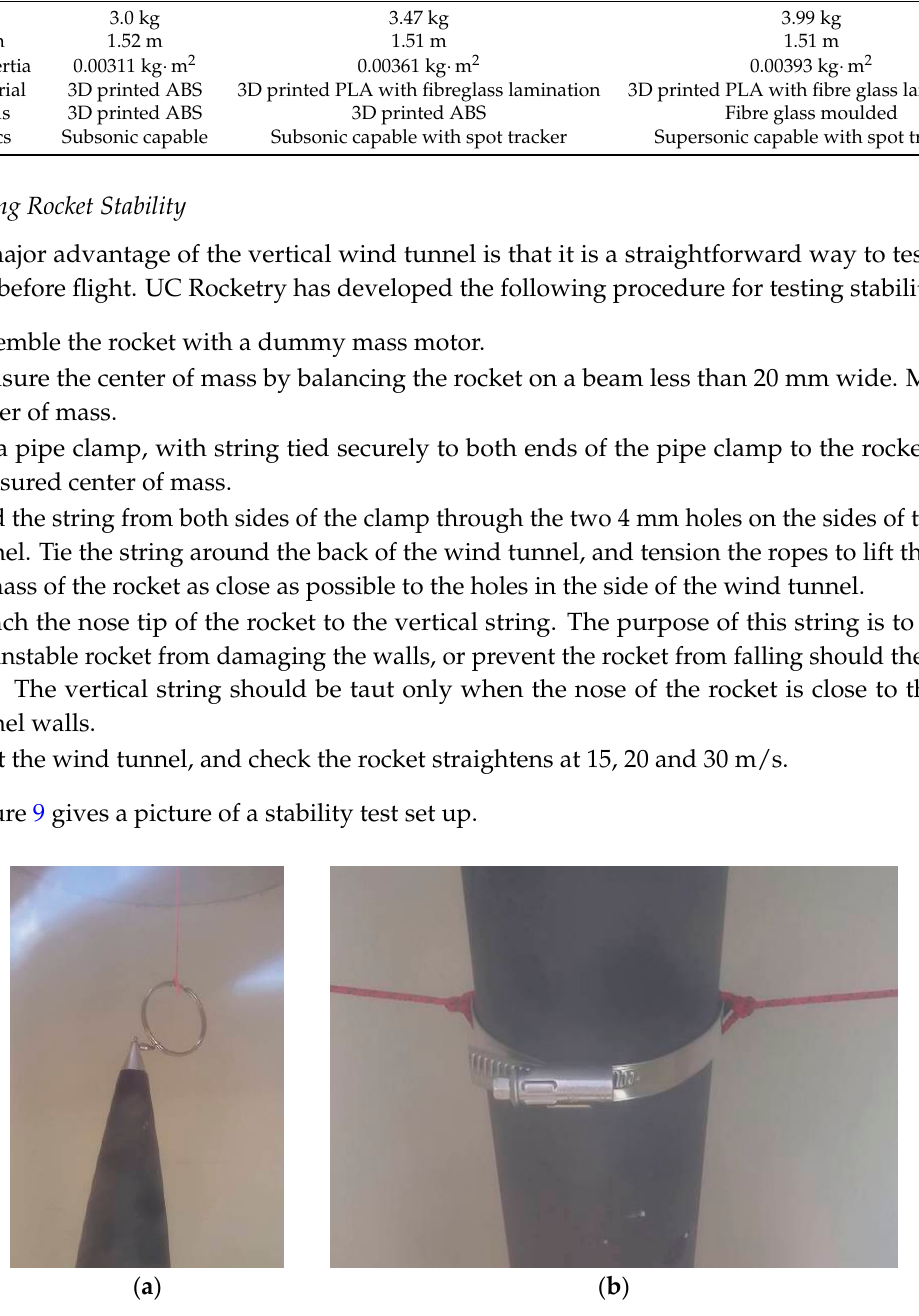
Table 1. Vehicle comparisons between Smokey and Tasha III.